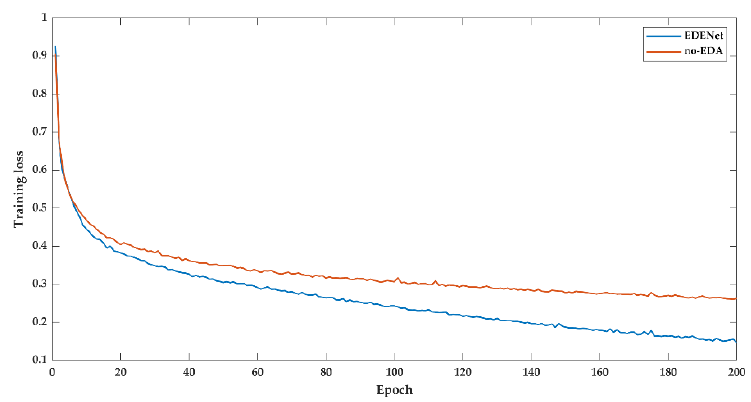
Figure A5. Training loss of DeepGlobe dataset.